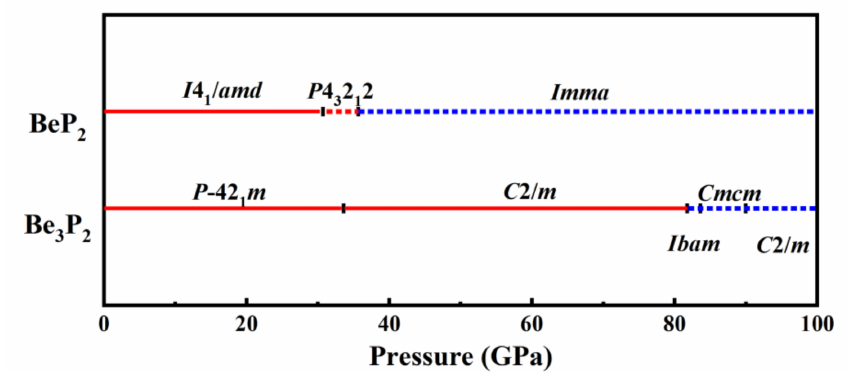
Figure 2. (color online). Be − P compounds composition-pressure phase graph. The metallic and insulating phases are represented by blue and red, respectively. Stable (metastable) phases are represented by solid (dashed) lines.